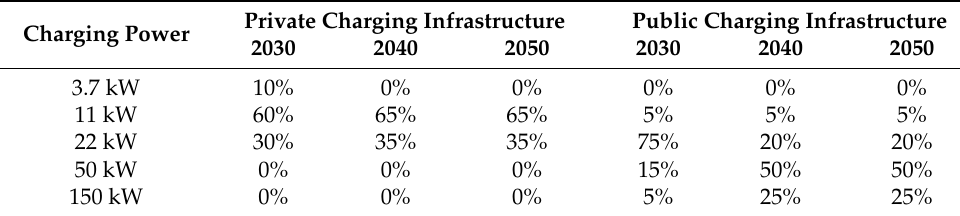
Table 1. The assumed distribution of charging powers for private and public charging infrastructure based on